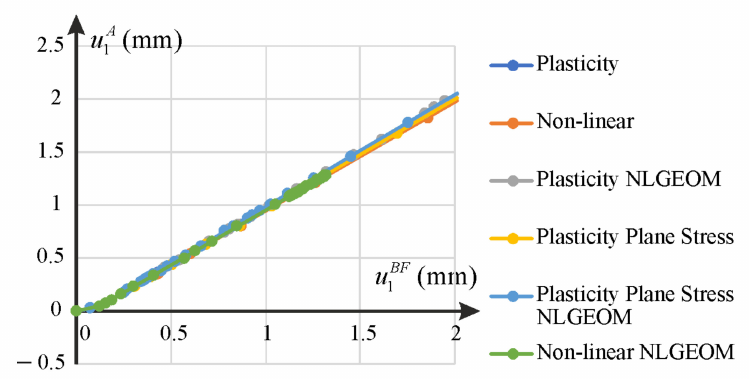
∈ [ 0,2 ]( mm ) , ( b ) u BF ∈ [ 0,0.4 ]( mm ) . 1 1